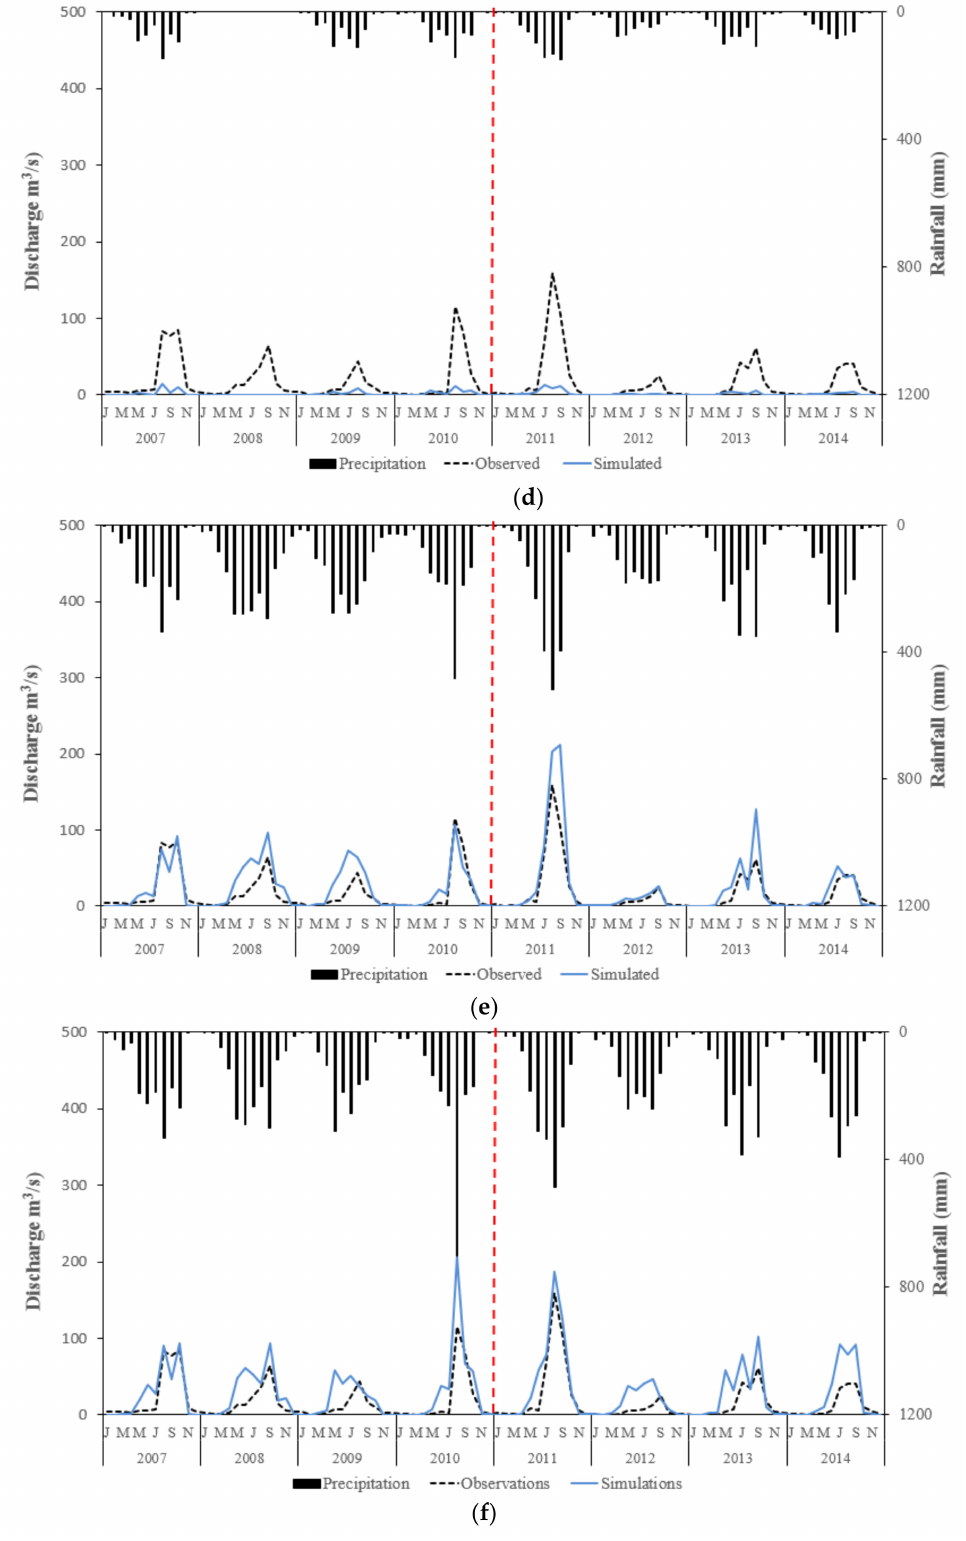
Figure 5. Simulated hydrographs under SbPPS and GbGPPs. ( a ) For observed rainfall; ( b ) For 3B42; ( c ) For 3B42-RT; ( d ) For CMORPH; ( e ) For APHRODITE V1901; ( f ) For